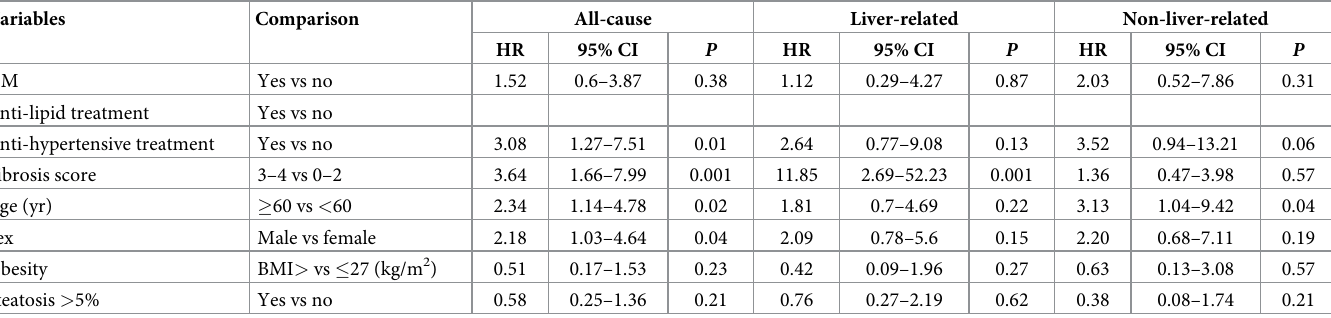
Table 8. Features Associated With Mortality In All Patients with SVR (N = 1124) According to Cox Proportional Hazards Model:Results of Multivariate Analyses.